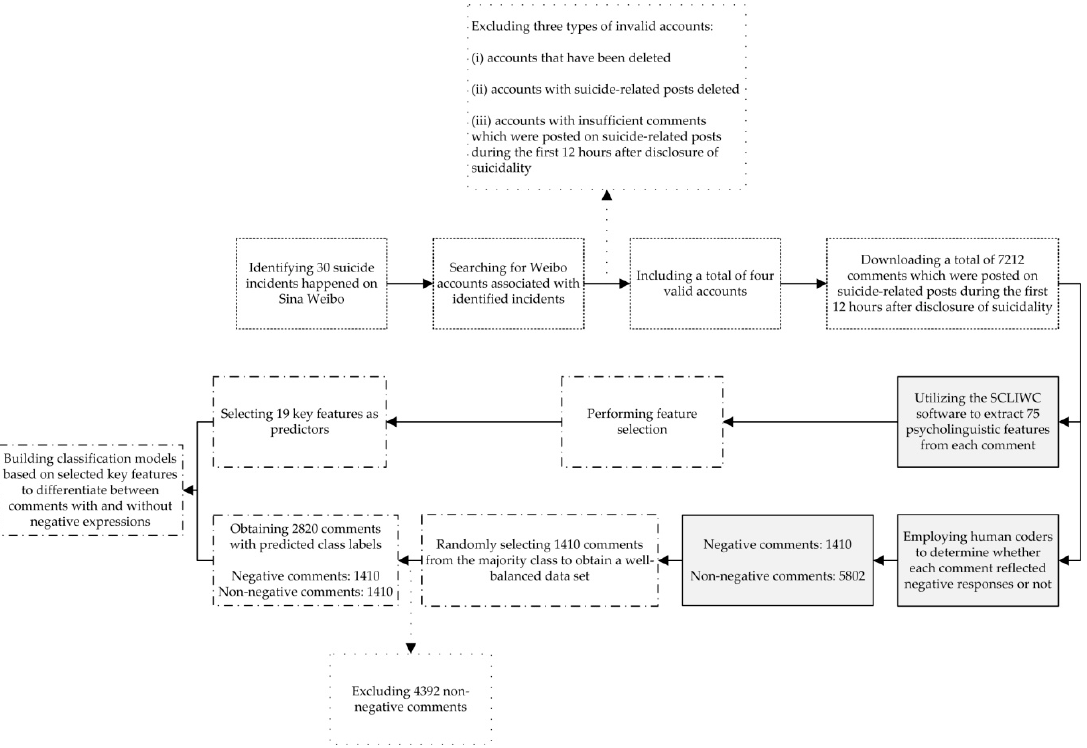
Figure 1. Research process. Table 1. Details of suicide